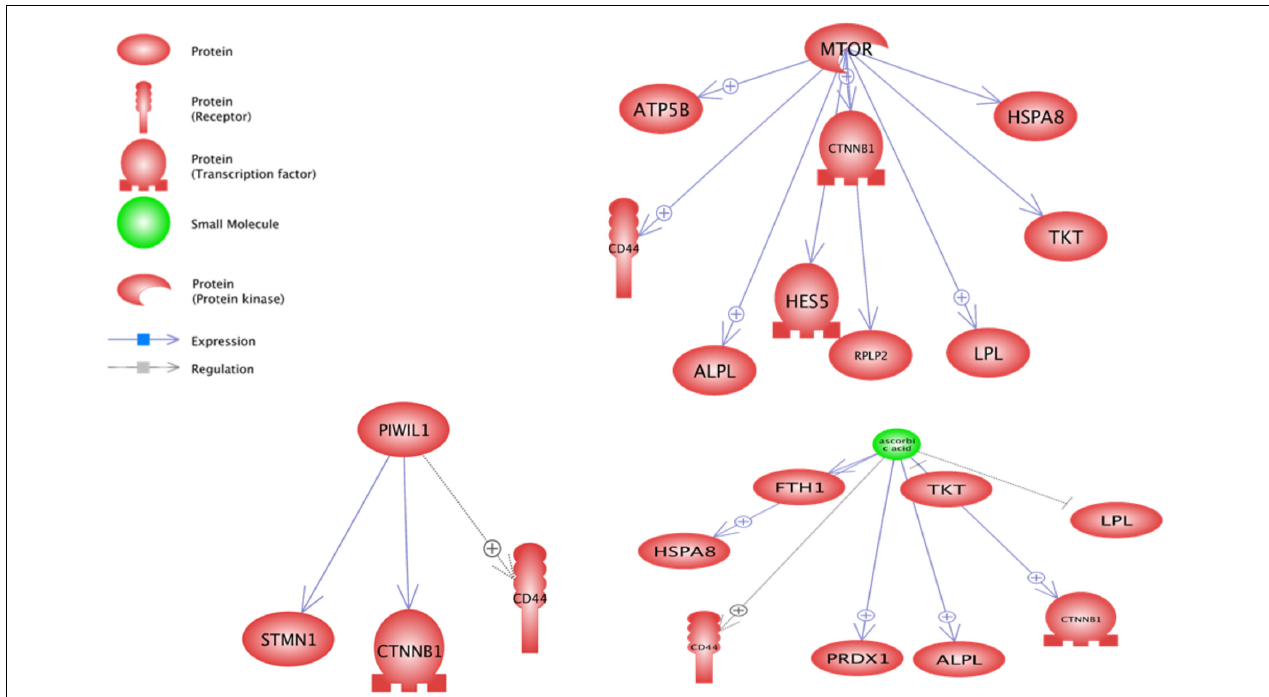
FIGURE 4 | Significant downstream sub-networks constructed by differentially expressed genes between pre-peak and post-peak milk production. L Represents positive-regulated and (cid:96) represents negative-regulated. PIWIL1, Ascorbic Acid and MTOR were the most important sub-networks.